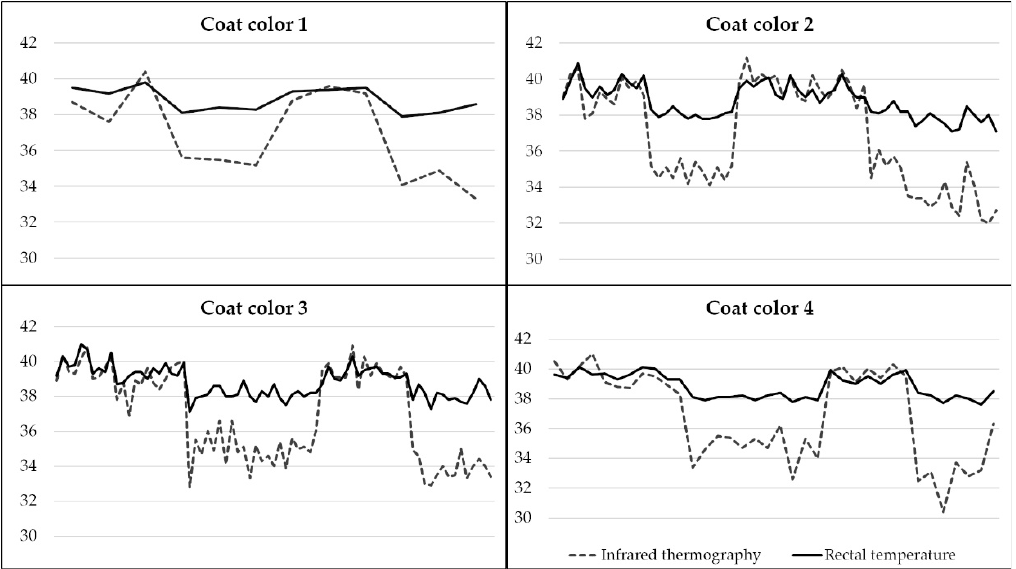
Figure 4. Coat color distribution according to rectal temperature (RT) and the superficial temperature of the lower side of the body (LS) obtained by infrared thermography. Coat color 1: cream; Coat color 2: yellow; Coat color 3: orange; and Coat color 4: red.